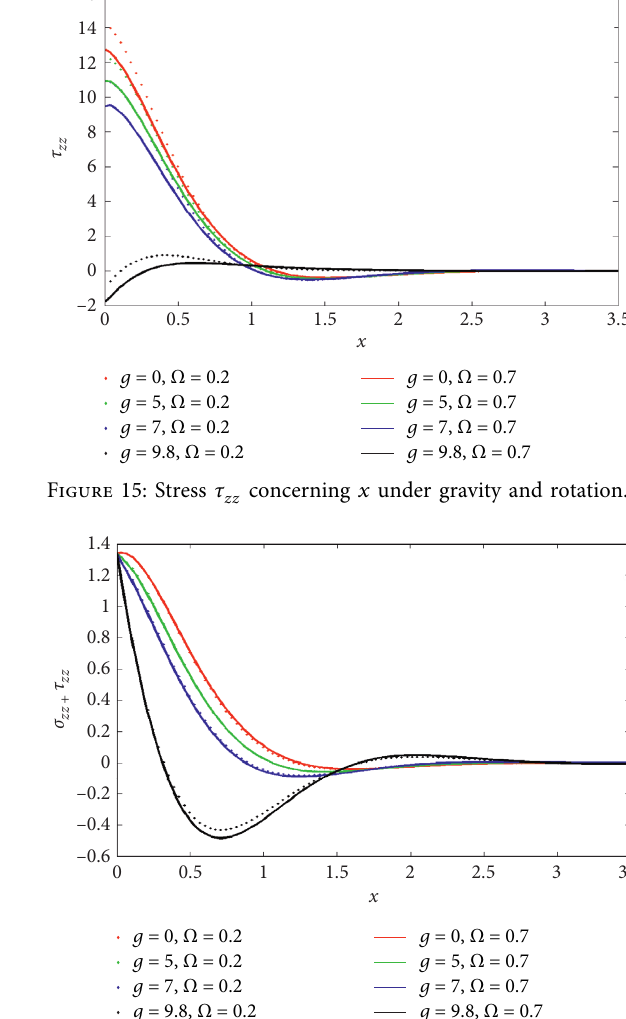
+ σ zz zz concerning